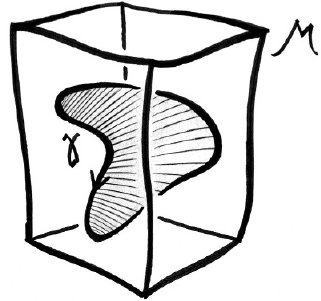
Figure 3 . Boundary gravitons in AdS 3 span an in(cid:12)nite-dimensional manifold M (cid:24) = Di(cid:11) S 1 = PSL(2 ; R ) (cid:2) Di(cid:11) S 1 = PSL(2 ; R ). Any loop (cid:13) in M encloses a two-dimensional surface embedded in M . The symplectic (cid:13)ux through that surface coincides with the Berry phase picked up by boundary gravitons as they undergo a family of conformal transformations whose projection on M is the path (cid:13)